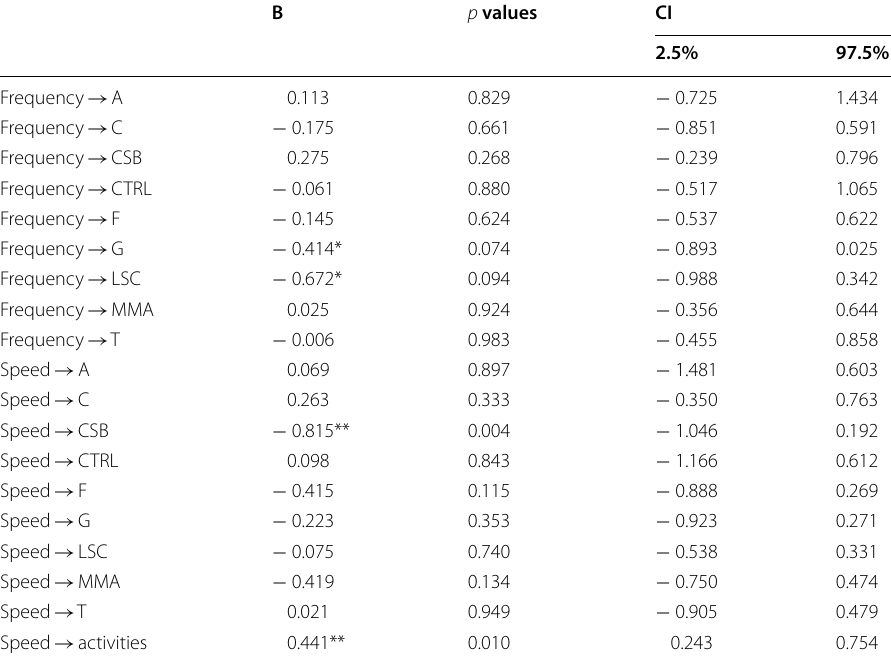
β regression coefficient, CI confidence interval, CSB challenge-skill balance, MMA action-awareness merging, G clear goals, F unambiguous feedback, C total concentration on the task at hand, CTRL sense of control, LSC loss of self-consciousness, T transformation of time, and A autotelic experience, Frequency frequency of students’ action, Speed speed of students’ action * p < 0.1 , ** p <